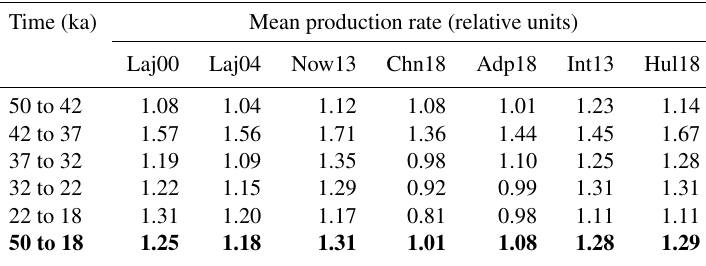
Table 2. Production rate estimates in relative units inferred from three fundamentally different reconstruction methods: geomagnetic field data from marine sediments, 10 Be and 36 Cl measurements in polar ice cores, and model-based deconvolution of atmospheric (cid:49) 14 C. Laj00, Laj04, Now13, and Chn18 refer to the paleointensity-based reconstructions of Laj et al. (2000), Laj et al. (2004), Nowaczyk et al. (2013), and Channell et al. (2018), respectively. Adp18 refers to the ice-core 10 Be-based reconstruction of Adolphi et al. (2018). Int13 and Hul18 refer to the model-based reconstructions from this study using the IntCal13 calibration curve (Reimer et al., 2013) and the new Hulu Cave (cid:49) 14 C dataset (Cheng et al., 2018). The bold numbers show the mean production rates during the last glacial (50 to 18ka). Time (ka) Mean production rate (relative units) Laj00 Laj04 Now13 Chn18 Adp18